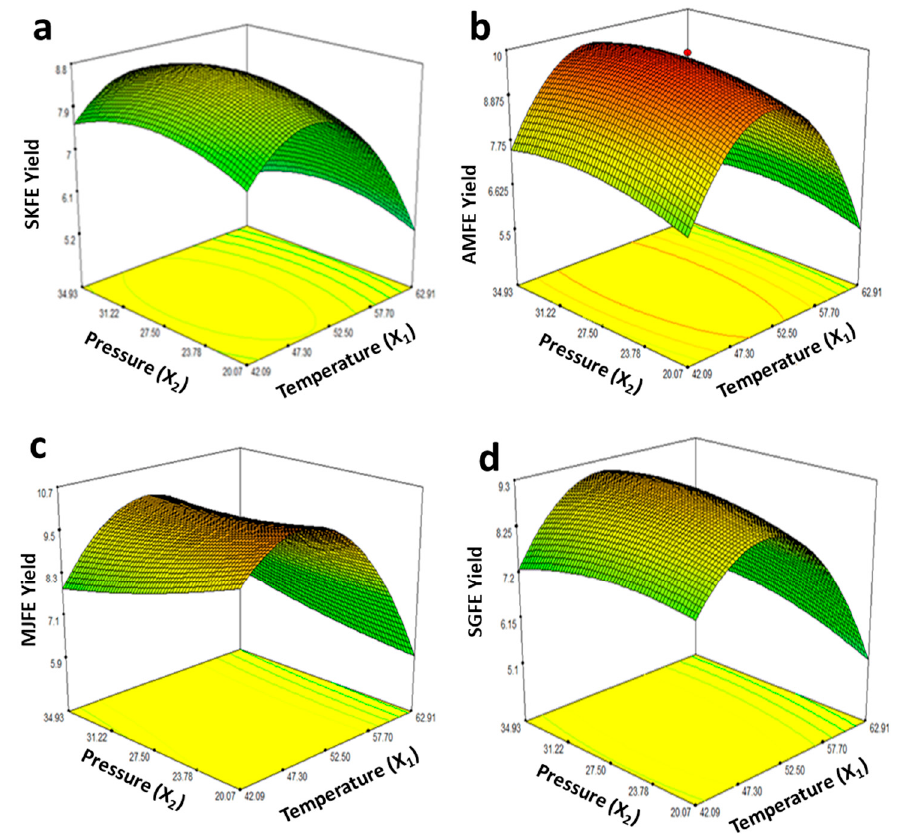
Figure 2. Response surface graphs showing relationship of supercritical fluid (CO 2 ) extraction (SFE) temperature and pressure (process variables) with extract yields (response variable) from Sukari (SKFE, ( a )), Ambara (AMFE, ( b )), Majdool (MJFE, ( c )) and Sagai (SGFE ( d )) flesh extracts.